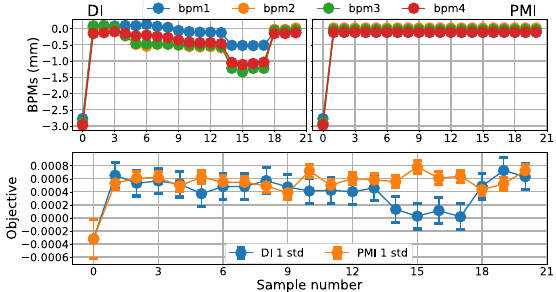
FIG. 13. Comparison of results from the optimization per- formed by the data-informed (DI, top left) and by the physics model-informed BO (PMI, top right). Both methods converge to the optimum solution very quickly. Moreover, the PMI method produces a more steady solution (top row), and hence a higher level of objective values (bottom